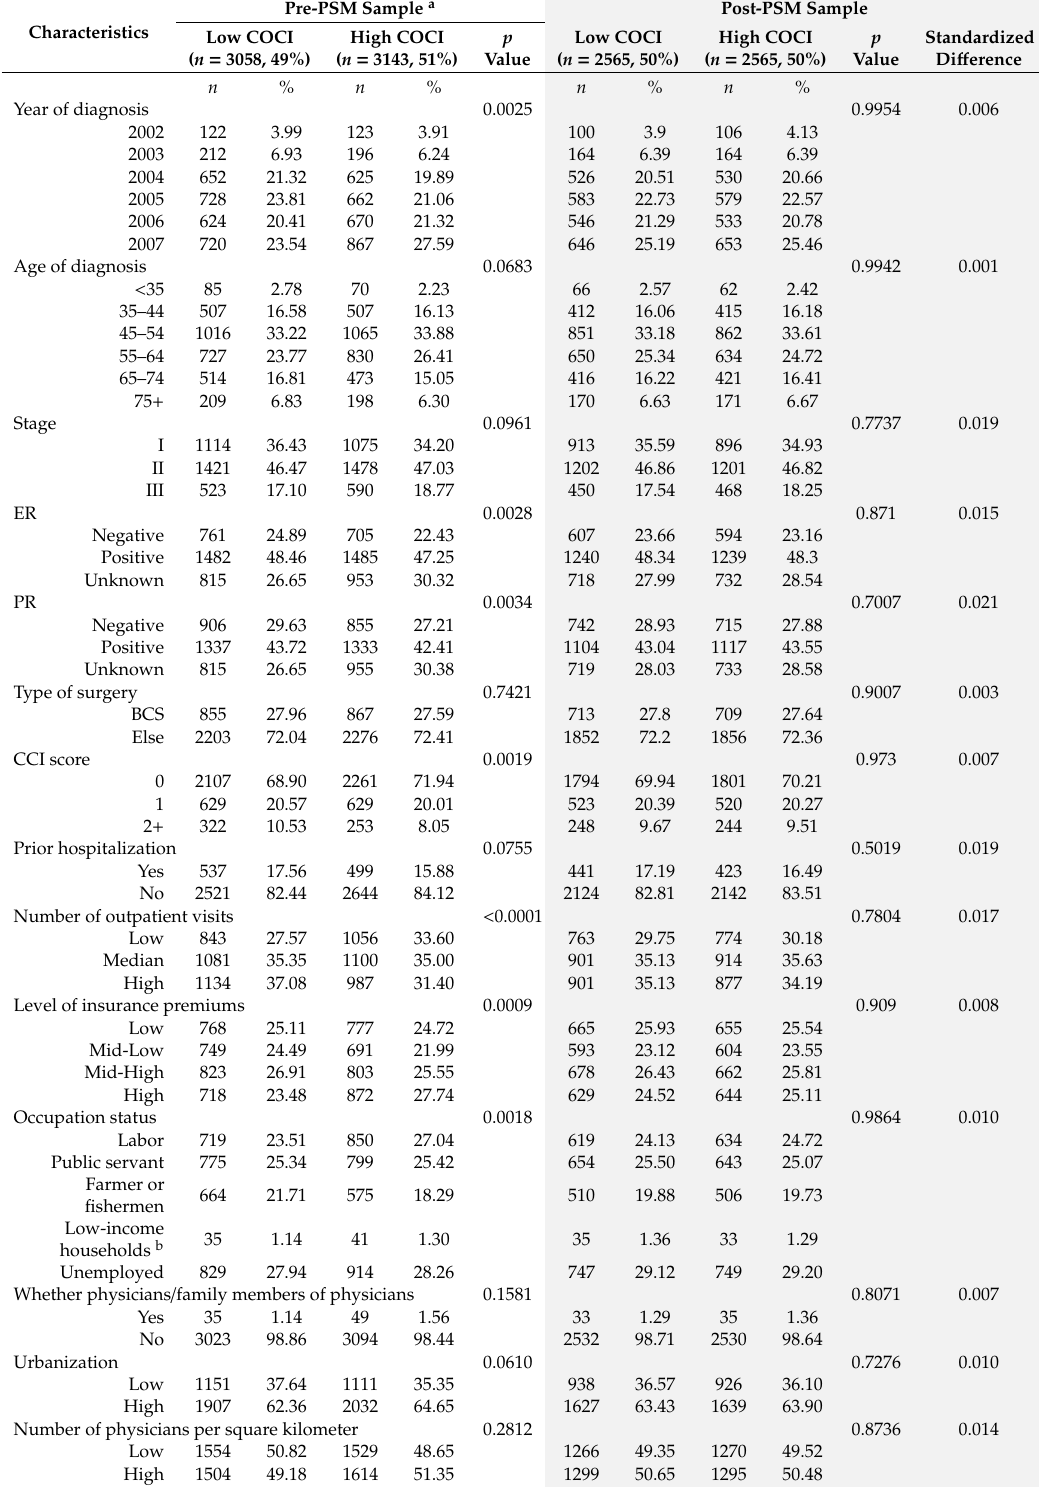
Table 2. Baseline characteristics of patients grouped according to the PCP continuity of care.